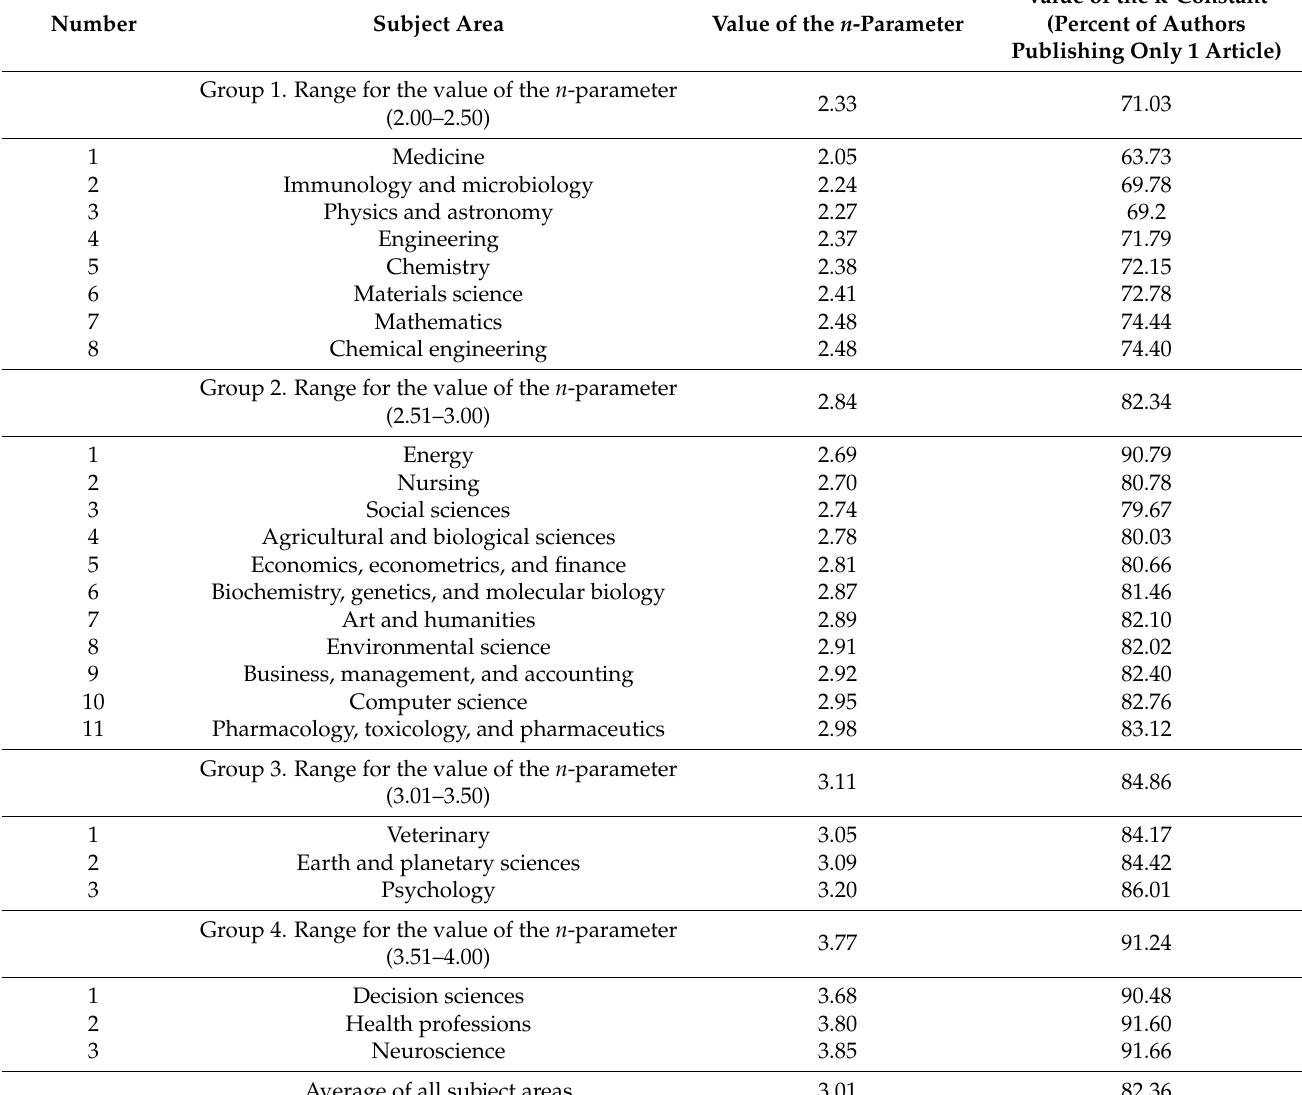
Table 6. Summary of the author-based research productivity analysis by Lotka’s